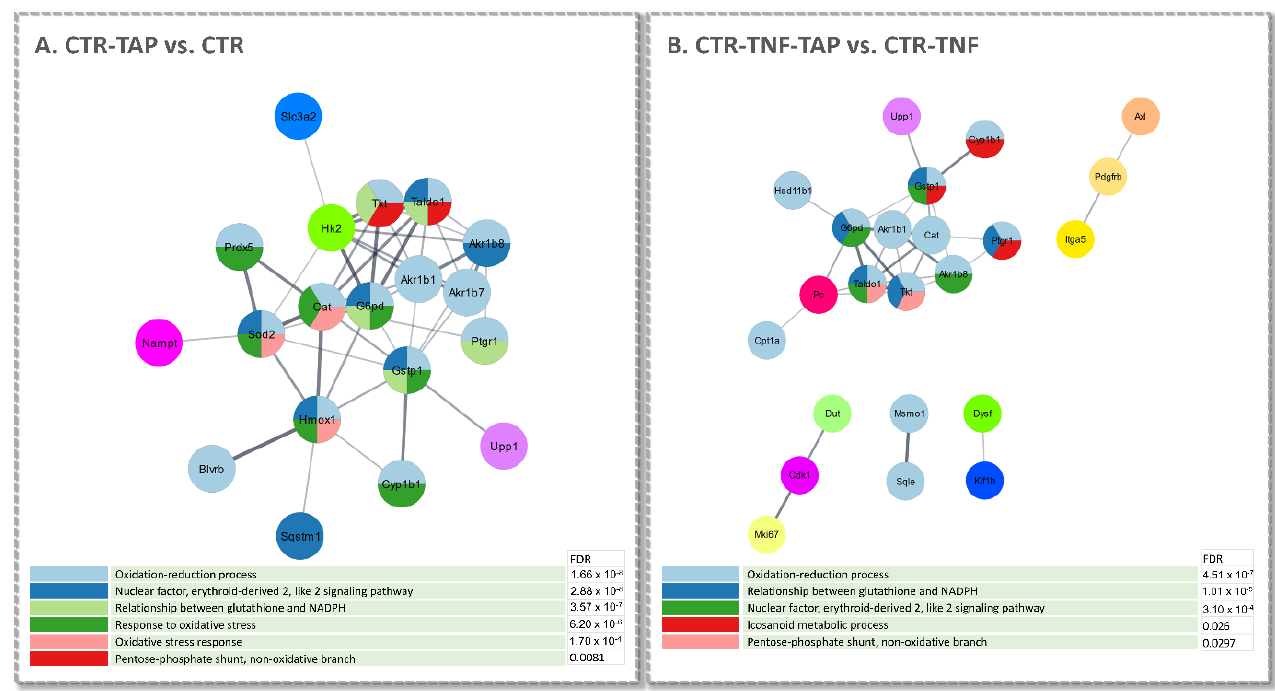
Figure 7. Cytoscape and STRING analysis of the up-regulated gene products determined by SILAC. The panels illustrate the protein – protein interaction networks obtained by STRING in the CTR-TAP vs. CTR ( A ) and CTR-TNF-TAP vs. CTR ( B ) conditions. The color/s of each node (gene product) reflect/s the functional enrichment analysis performed; the color code describing the enriched bio- logical processes with the corresponding FDR value is shown below each network. In both analyses, the singlets were left